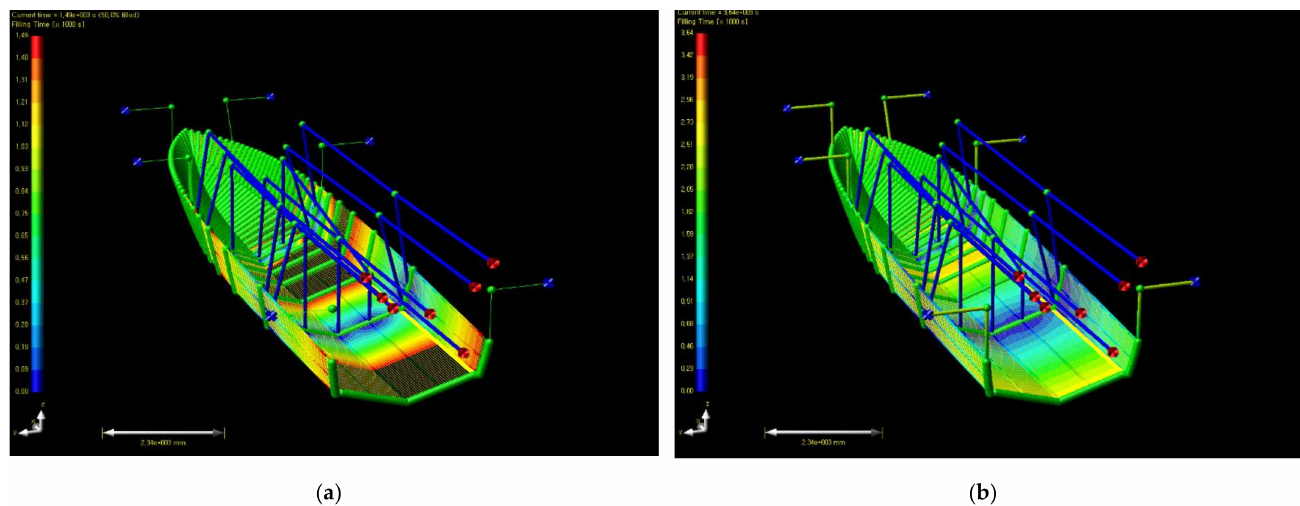
Figure 12. Resin flow analysis result of case 3 (filling time): ( a ) 50% filled; ( b ) 100% filled.